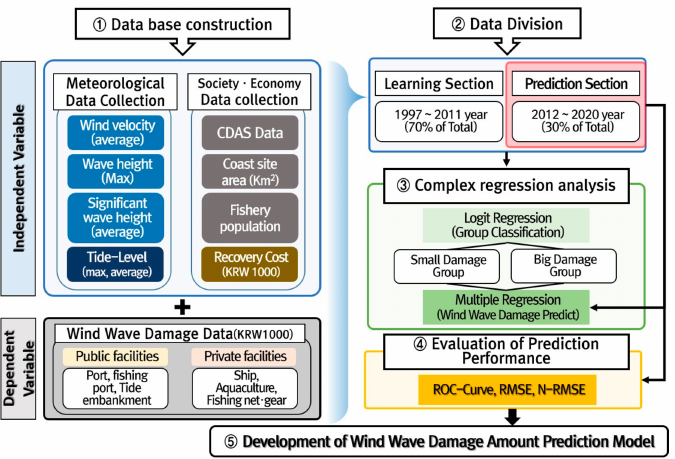
Figure 1. Precedure to Develop Wind Wave Damage Amount Prediction